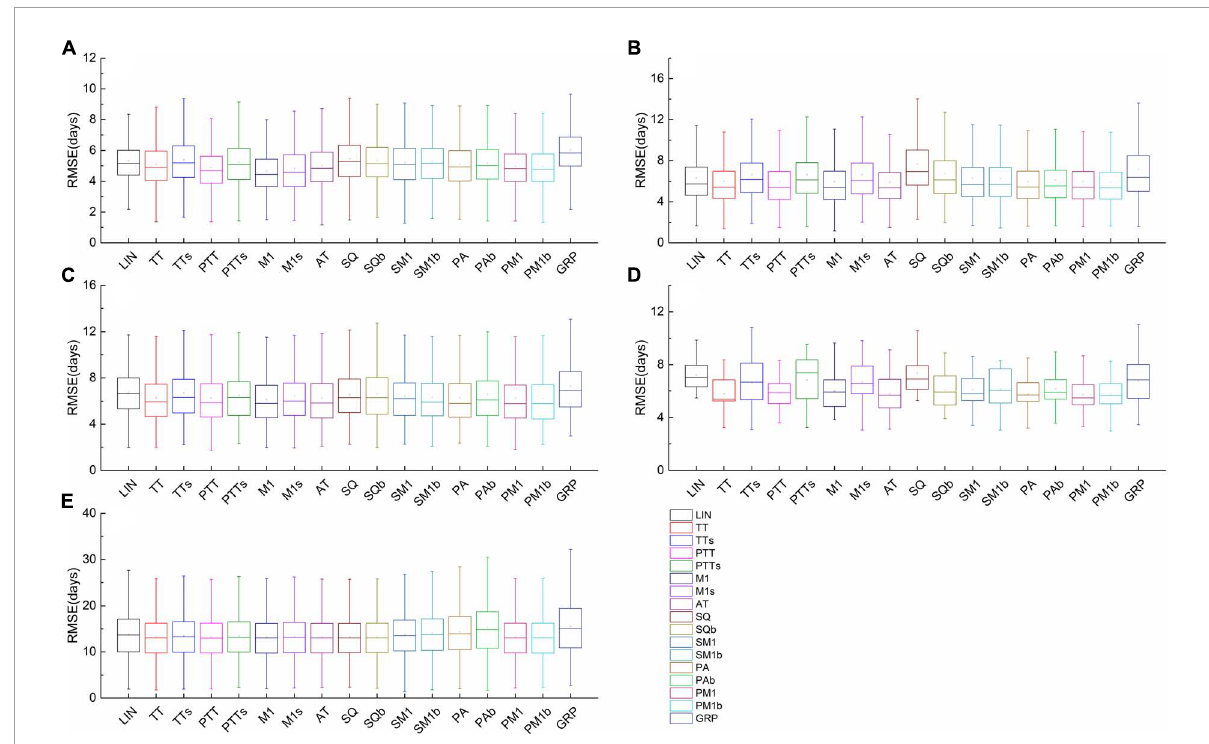
FIGURE3 Comparison of the results of 17 spring phenological models for five vegetation types: (A) deciduous needleleaf forest (DNF), (B) mixed forest (MF), (C) open shrublands (OSL), (D) woody savannas (WS), and (E) grasslands (GL). The five panels show box plots of the root mean square error (RMSE) between the start of the growing season (SOS) predicted by the 17 models used in this study and the satellite-derived SOS. The RMSEs were calculated from the validation